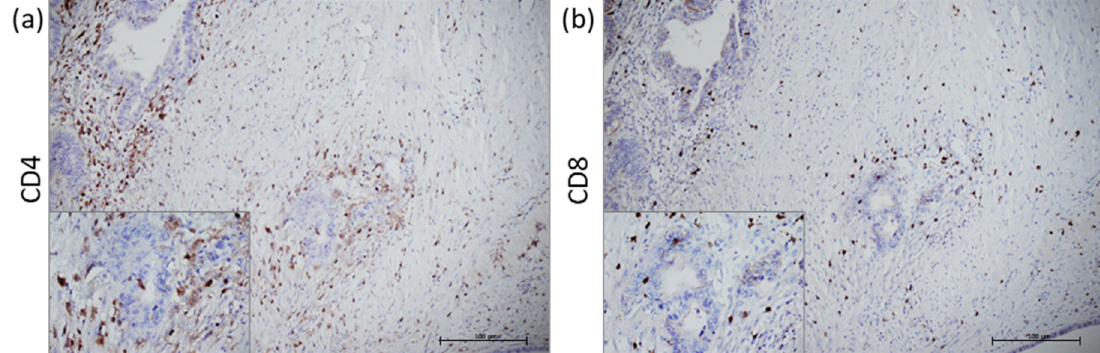
Figure 3. CD4 and CD8 immunostaining. Representative histologic images of CD4 + ( a ) and CD8 + immune cells ( b ).